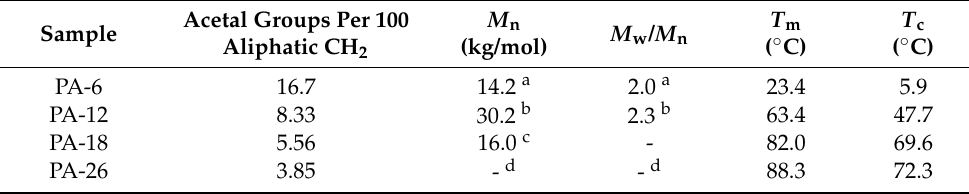
Table 1. Molecular mass characterization of even long-spaced polyacetals.